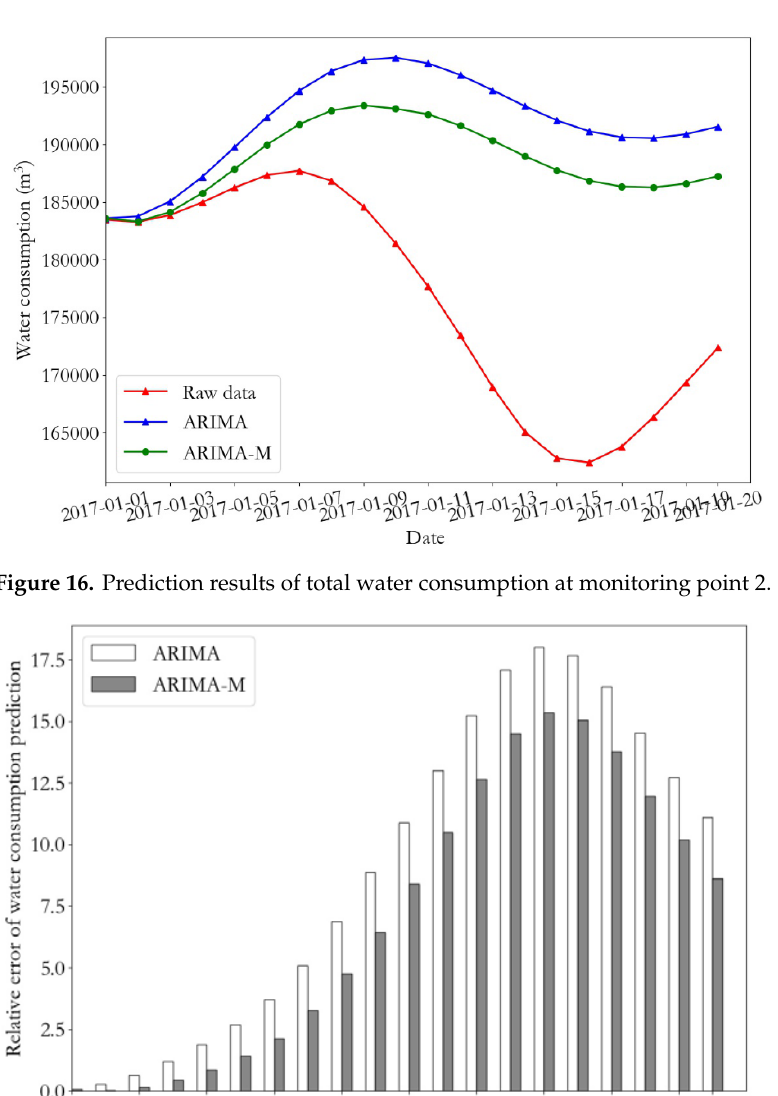
Table 10. Prediction error of test set for monitoring point 1.